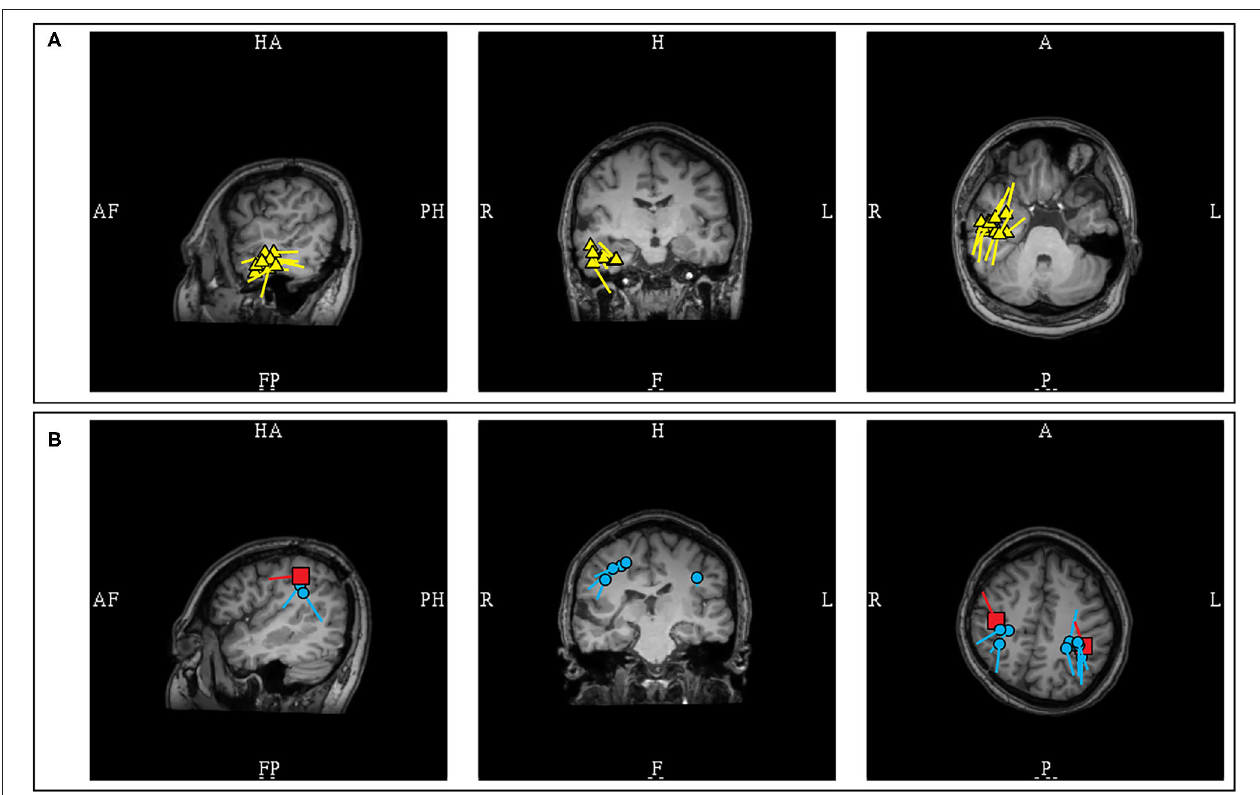
FIGURE 12 | MEG-MRI coregistration summary demonstrating dipoles in a patient with extensive right hemispheric cortical malformation. (A) A cluster of likely pathologic right temporal dipoles (yellow) was identified. (B) Bilateral parietal dipoles (blue) were also identified in proximity to somatosensory dipoles (red). These dipoles near the somatosensory area, and without an EEG correlate, were considered benign and were not included in final surgical